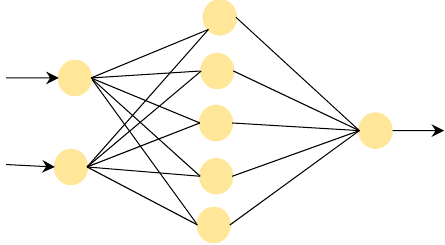
Figure A4. The architecture of Artificial neural networks.